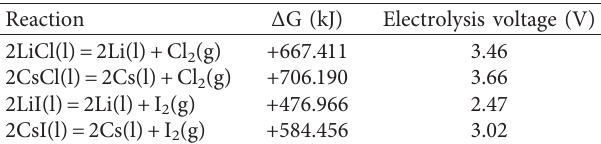
Figure 2: Current-voltage characteristics of the LiCl, LiCl-CsI, LiCl-LiI, and LiCl-CsCl molten salts: (a) original data and (b) normalized data. Table 1: Δ G values and corresponding electrolysis voltage of decomposition reactions of LiCl, CsI, CsCl, and LiCl at 650 °